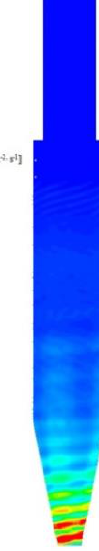
Figure 7. Contour plot of the particles erosion rate on the cyclone wall.